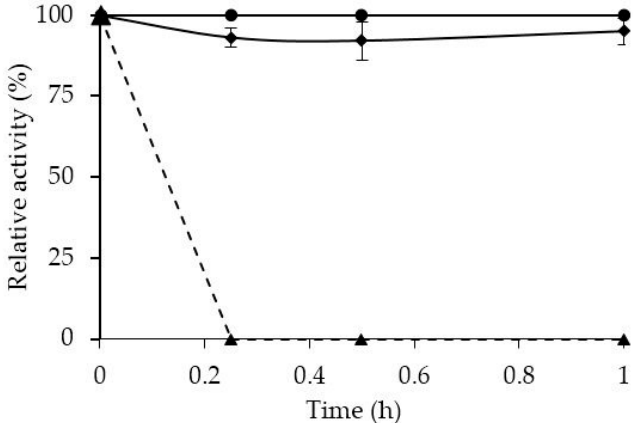
Figure 1. Immobilization courses of CALB at pH 7 on octyl agarose at low ionic strength. Rhombi, solid line: suspension; triangles, dashed line: supernatant; circles, solid line: reference.